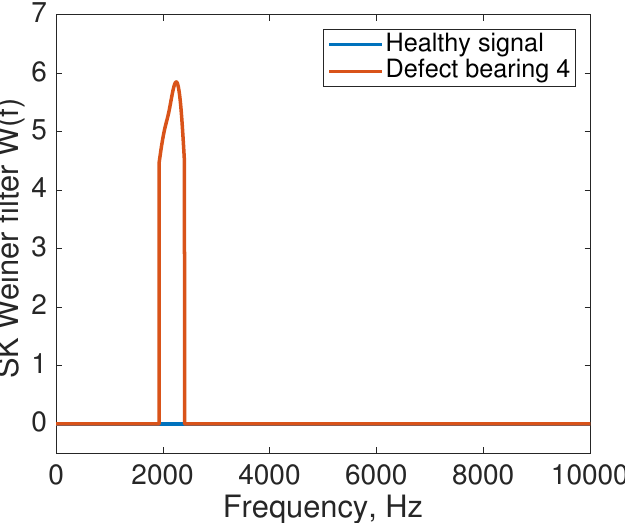
Figure 8. SK –based wiener filter extracted from SK curve through thresholding at 20 units.